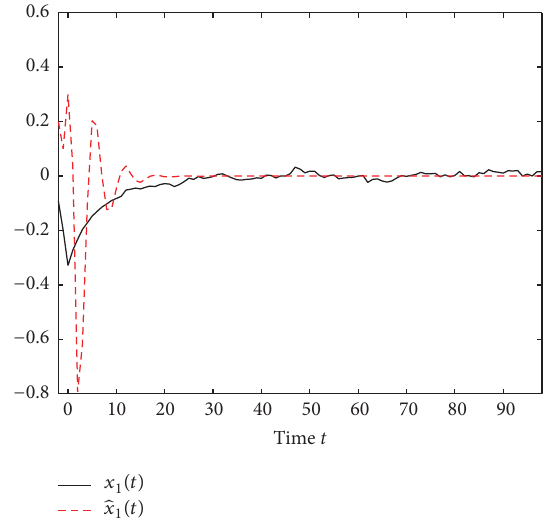
Figure 2: Evolutive behavior of 𝑥 1 (𝑡) and ̂𝑥 1 (𝑡)